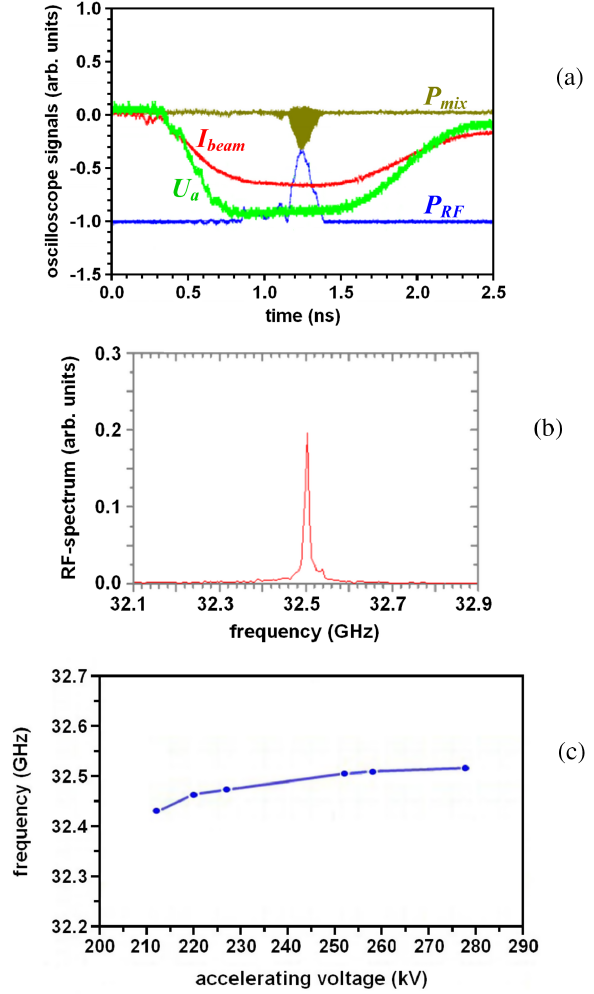
FIG. 9. Results of experimental studies of oversized Ka-band SWOs based on the SATURN accelerator: (a) typical oscillo- scope traces of the accelerating voltage U (green curve), beam a current I (red curve), signal from a heterodyne mixer P beam mix (brown curve) and output rf-pulse P (blue curve); (b) spectrum rf of the output radiation and (c) dependence of the radiation frequency on the accelerating voltage.